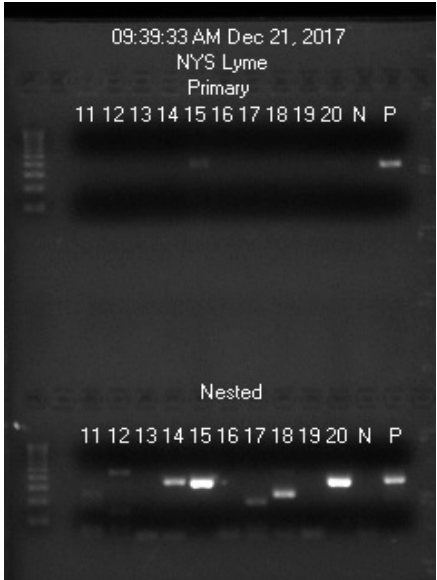
Figure 3. Image of an agarose gel electrophoresis showing 10 primary (upper) and the corresponding second (same-nested) PCR products (lower, labeled as Nested) generated with the M1/M2 primer pair on a panel of blind-coded blood samples received from New York State Department of Health for a Borrelia burgdorferi direct detection proficiency test.